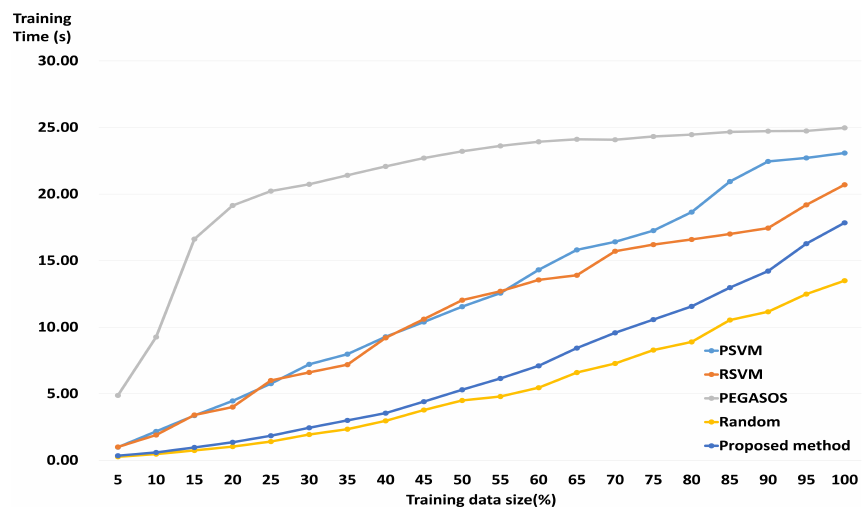
Figure 6. Computation time for training procedure based on selected training data on all